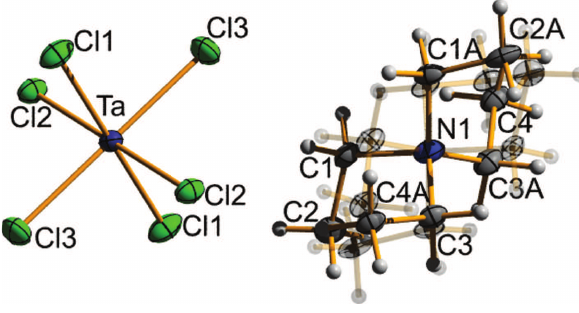
Table 1: Data collection and handling.